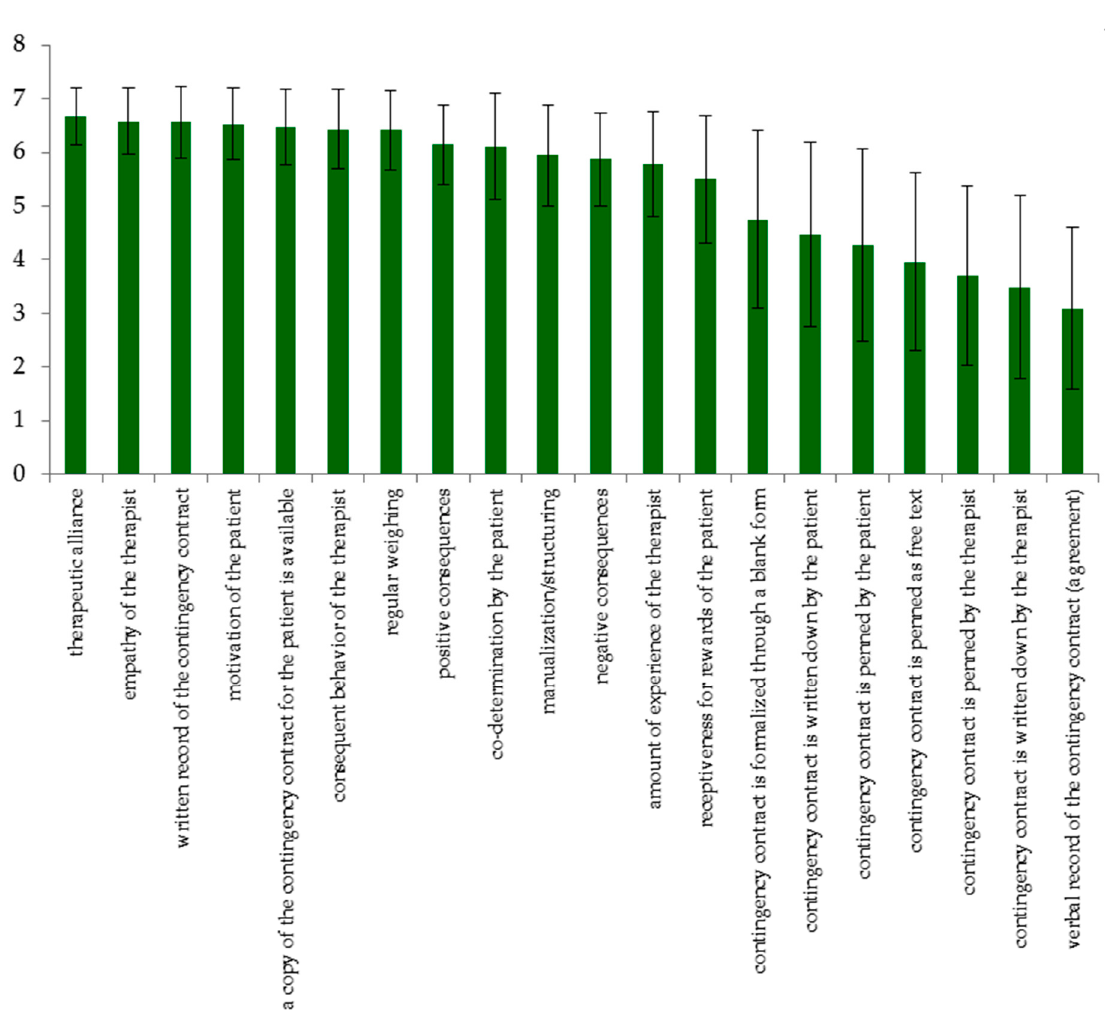
Figure 1. Factors of success of contingency contracts for anorexia nervosa (AN) by expert ratings. Factors of success were rated on a 7-point Likert scale from 1 ‘not important at all’ to 7 ‘very